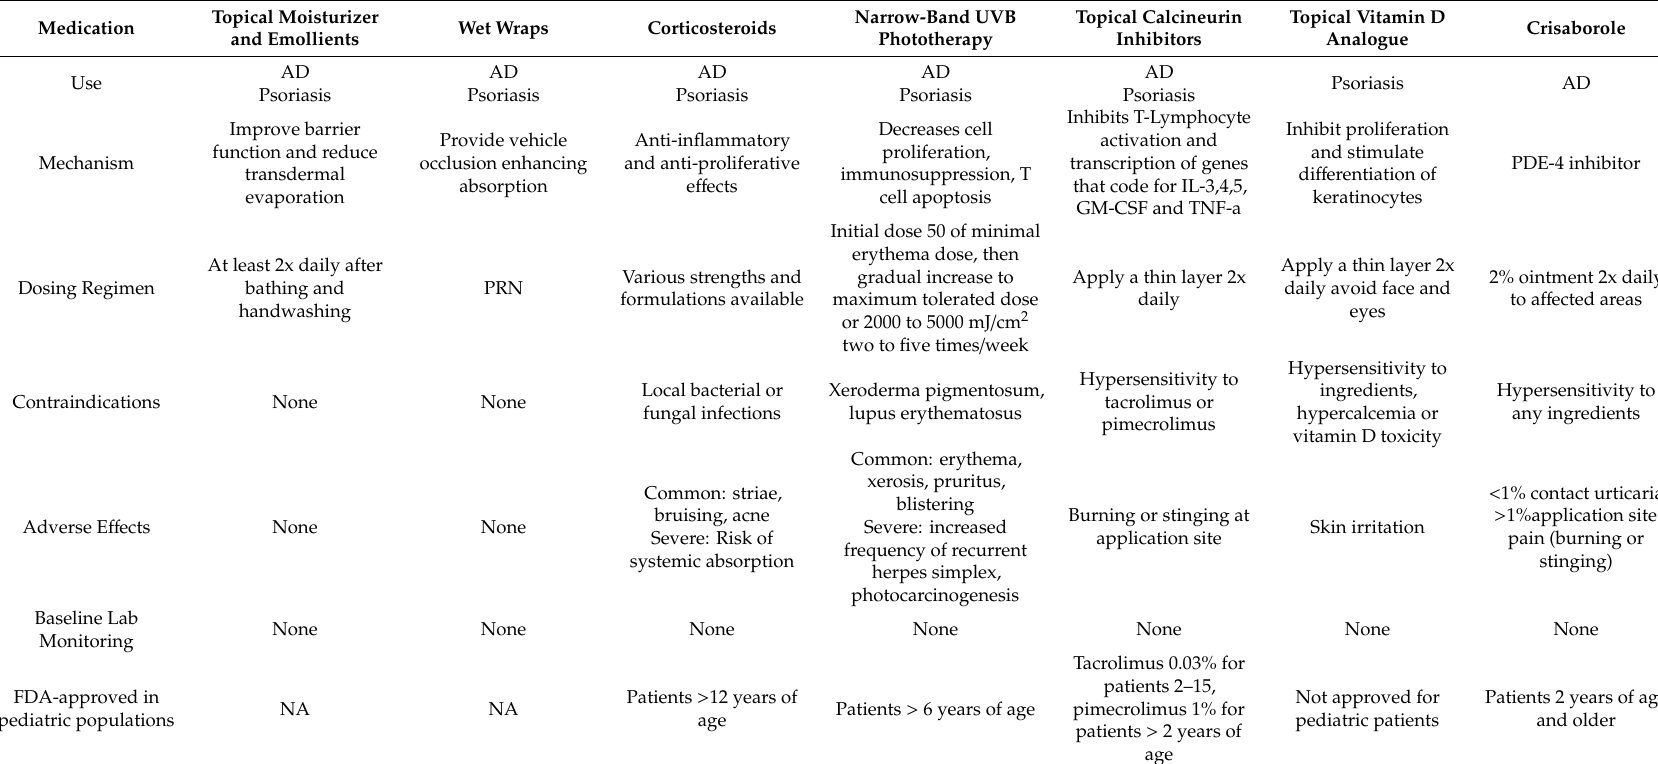
Table 1. Topical treatments in pediatric atopic dermatitis and psoriasis